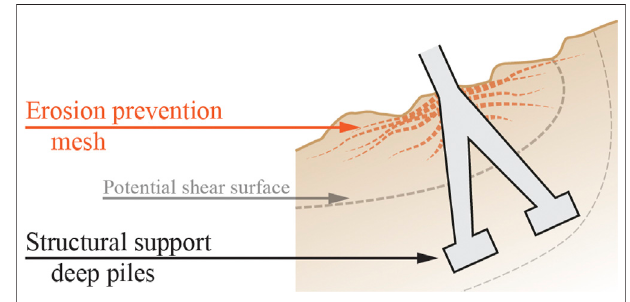
FIGURE 1 | Soil retaining concept of a foundation on sloped terrain — The primary deep foundation piles support the structure beyond the potential shear surface and the secondary root-inspired network holds soil particles in place.